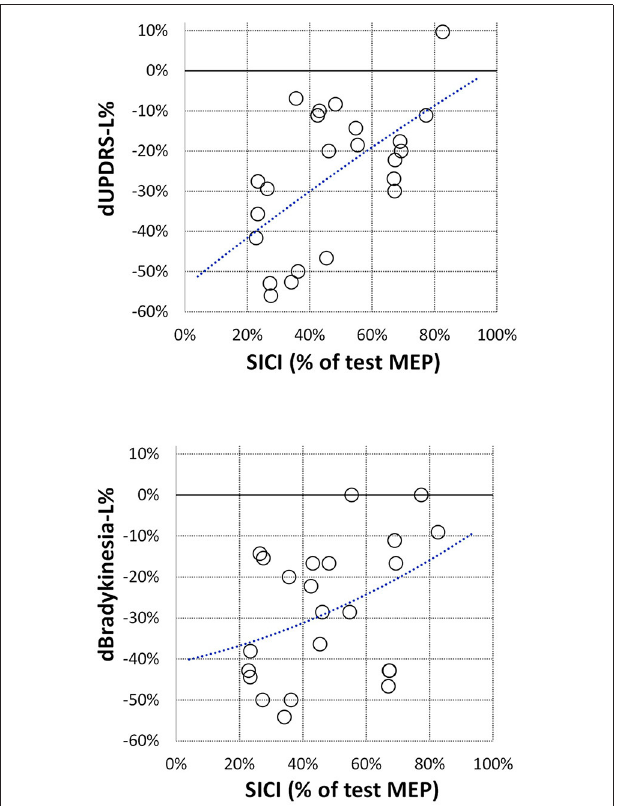
FIGURE 2 | Correlation between off-medication SICI and relative changes in lateralized UPDRS sub-score (dUPDRS-L%) and in lateralized bradykinesia sub-score (dBradykinesia-L%). SICI is presented the same as in Figure 1 ; relative changes in clinical sub-scores are presented as ratios (on-medication–off-medication)/off-medication . The polynomial regression lines are plotted on each graph for illustrative purposes only.